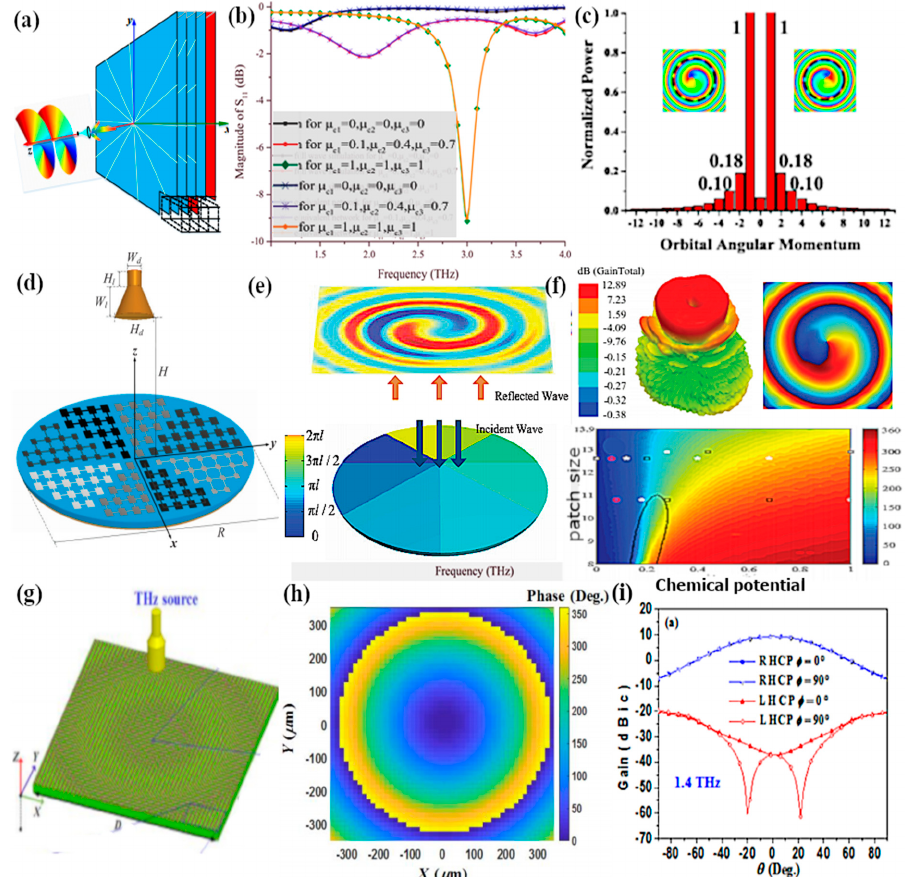
Figure 18. ( a ) Schematics of graphene reflectarray geometry for the generation of vortex beams; the whole reflectarray is divided into sectors for the different phase tuning. ( b ) Resonating frequency of the proposed graphene reflectarray, by proper tuning of the chemical potential. ( c ) Orbital angular momentum at different vortex modes. ( d ) Geometry of a reconfigurable graphene reflectarray antenna, where dark and bright sectors of the graphene patches correspond to different chemical potentials. ( e ) Reflective surface model for the generation of vortex waves; different sectors have varying phase when excited by a plane wave. ( f ) 3D radiation gain pattern showing a high achieved gain of 12.89 dBi and reflection coefficient with various patch sizes and chemical potential values. ( g ) Structure of circularly polarized graphene reflectarray with circularly polarized source. ( h ) Distribution of the reflected phase of the reflectarray employing a metasurface. ( i ) 2D radiation pattern of the circularly polarized graphene reflectarray at 1.4 THz; the blue line represents the right-handed circular polarization (RHCP) and red lines represent left-handed circular polarization (LHCP). © 2019 OSA, © 2018 AIP, © 2018 MDPI. Reprinted with permission from [240], [241], [243].